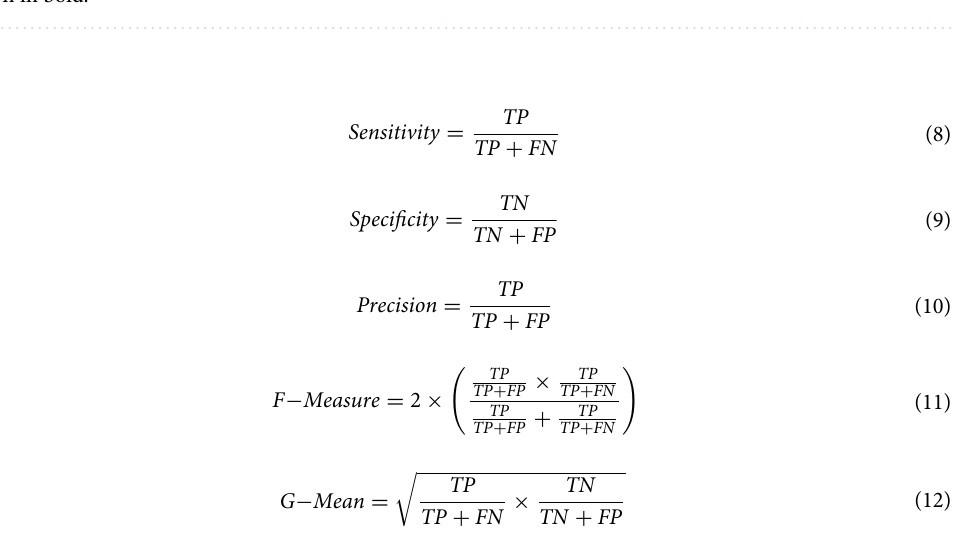
Table 3. Performance comparison for the identification of image modality. Best result for each metric is shown in